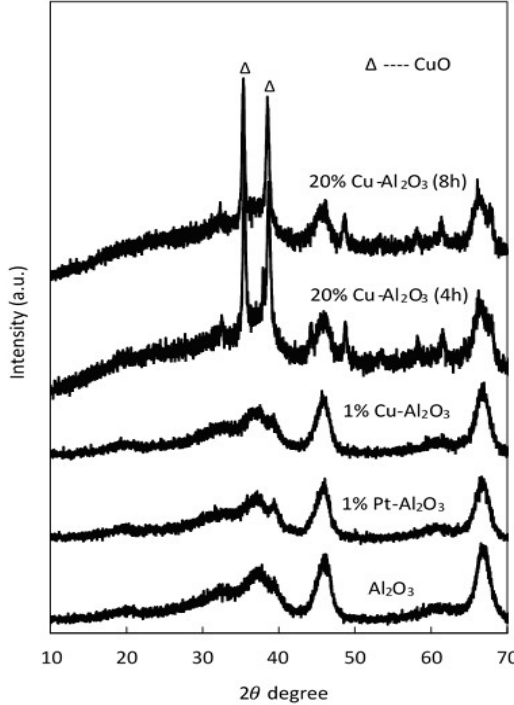
ff erent supported